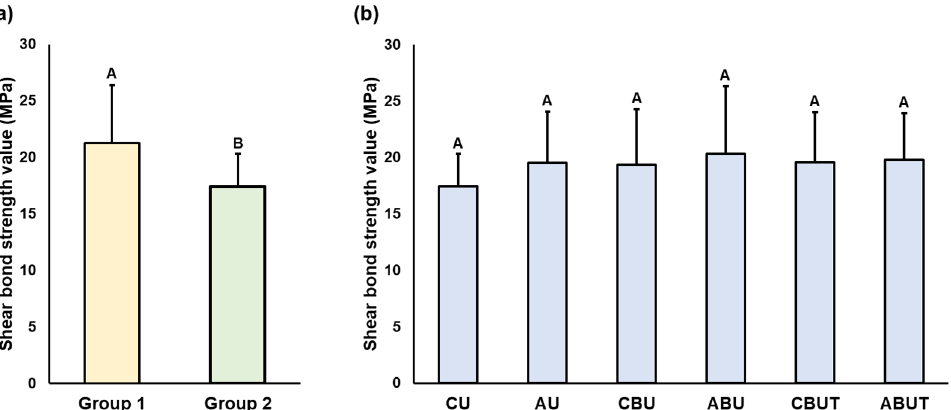
Figure 2. Results of the two-way ANOVAs of shear bond strength (SBS) before thermocycling ( a ) between Groups 1 and 2 and ( b ) between the groups with different adhesion conditions. Uppercase letters indicate significant differences. Data are the means and SD values.